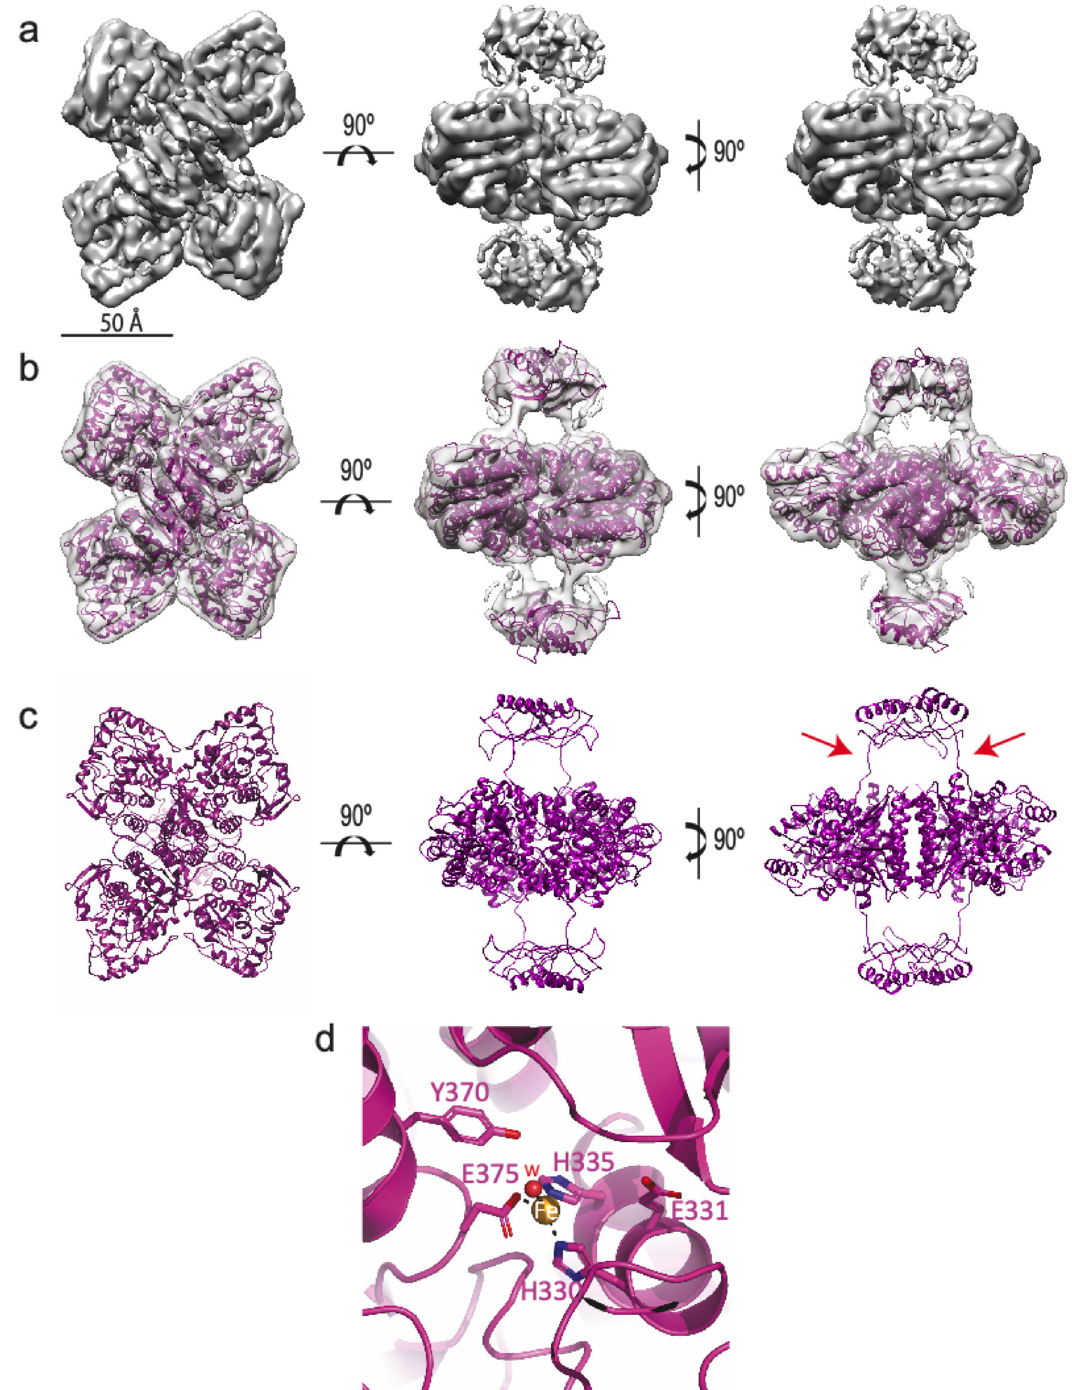
Fig. 1 Structure of the human tyrosine hydroxylase (apo-TH). a Three orthogonal views of the Cryo-EM map showing the main features of the full-length apo-TH at 3.9A ̊ resolution. The scale bar indicates 50 Å. b The same views with the fl exible fi tting with iMOD fi t 1.51 of the atomic model in the 3D map for further sharpening steps. c Atomic model of the CD + OD and RD domains built from the Cryo-EM 3D reconstruction. The connections between the RD and CD are highlighted with red arrows on one side of the structure. In the left fi gure, the RD has been made slightly transparent for the CD + OD domains to be better observed. d Detail of the active site of apo-TH showing the iron coordination with H330, H335 and